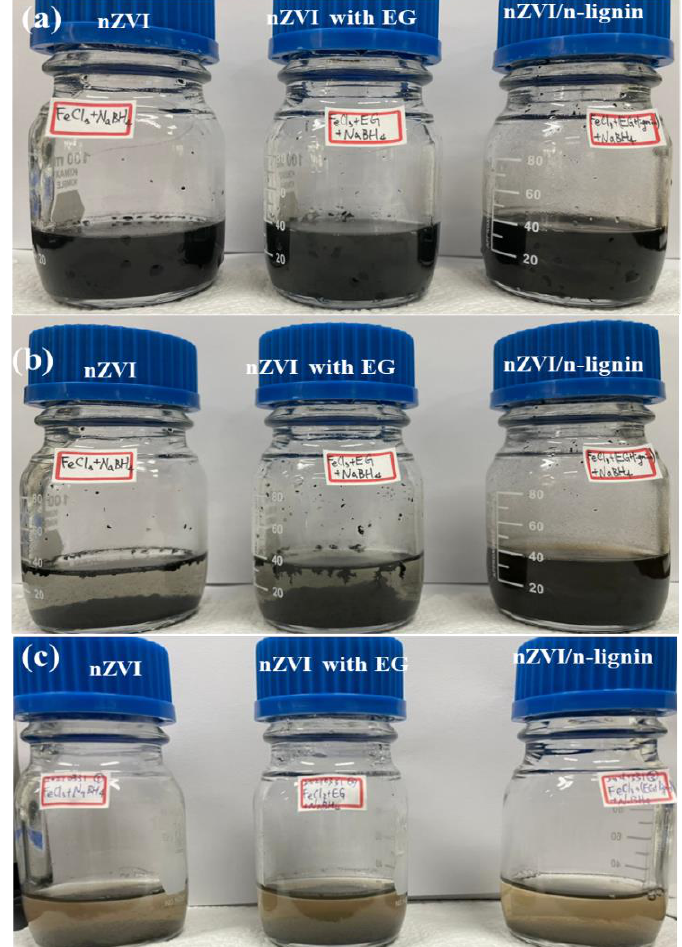
Figure 6. Dispersibility in H 2 O of bare nZVI, EG-functionalized nZVI, and nZVI/n-lignin: ( a ) after the sonication, ( b ) standing for 60 min, and ( c ) standing for 1 day.